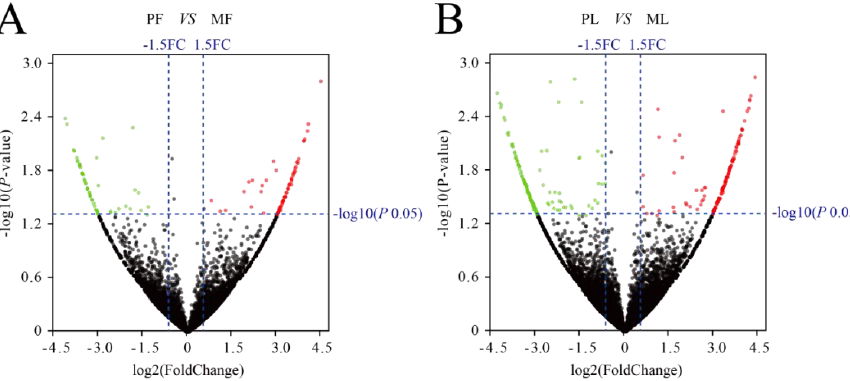
Figure 2. Analysis of differentially expressed circRNAs. ( A ) Differentially expressed circRNAs in the follicular phase. ( B ) Differentially expressed circRNAs in the luteal phase. Red, green, and gray dots in the graph represent transcripts that were significantly up-regulated, down-regulated, or unchanged respectively, between polytocous and monotocous sheep.